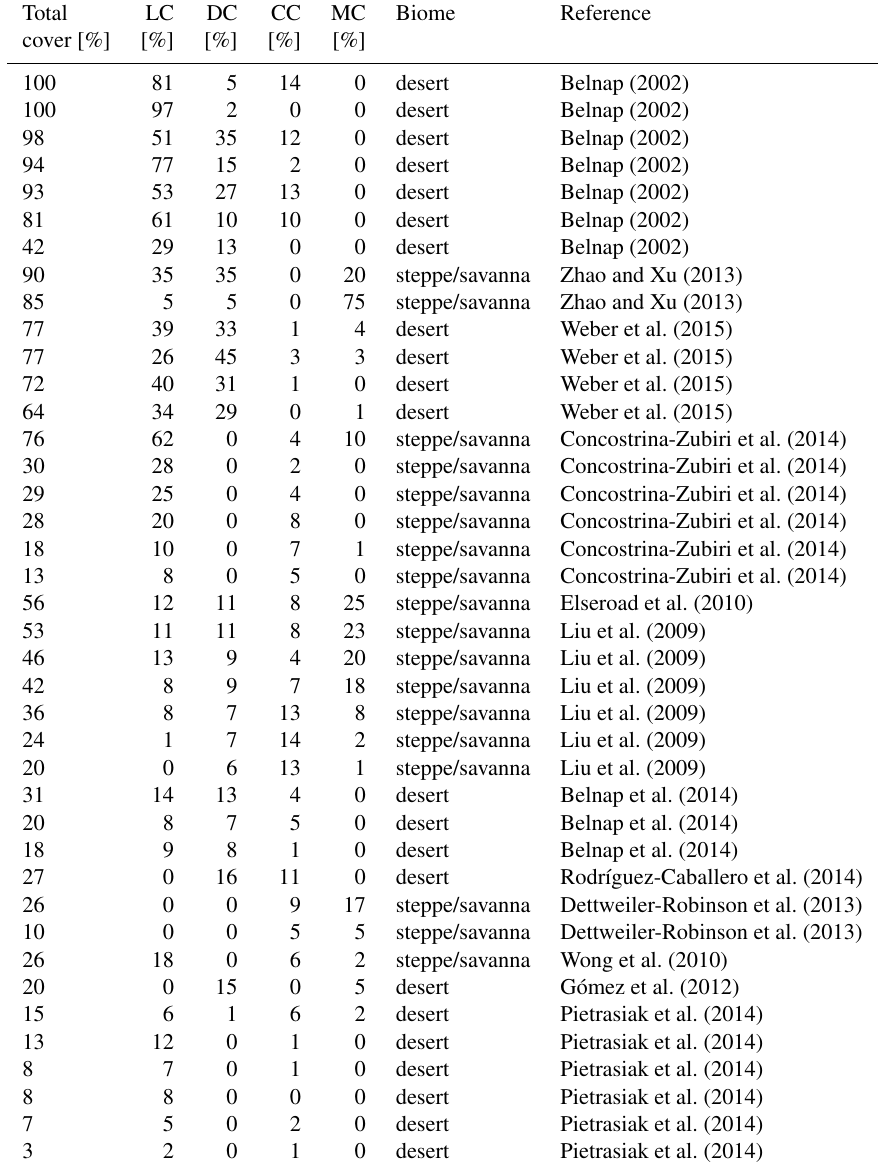
Table A2. Studies reporting values of total biocrust cover and relative cover of four biocrust types which are used in the model–data comparison (Fig. 8). The abbreviations stand for light cyanobacteria-dominated (LC), dark cyanobacteria-dominated (DC), chlorolichen- dominated (CC), and moss-dominated (MC) biocrusts. All cover values are in